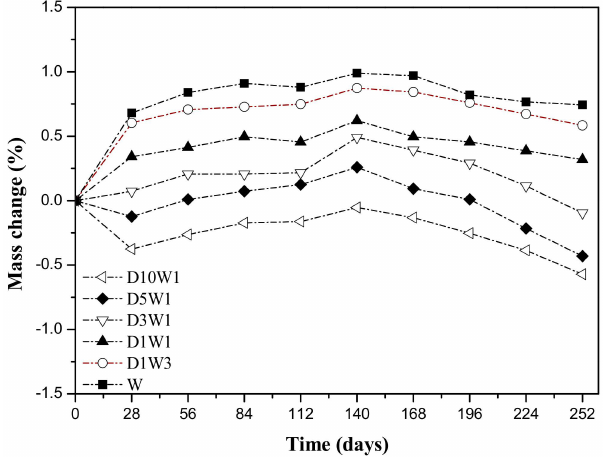
Figure 5. Mass change of specimens exposed to sulfate solution under di ff erent drying–wetting cycle